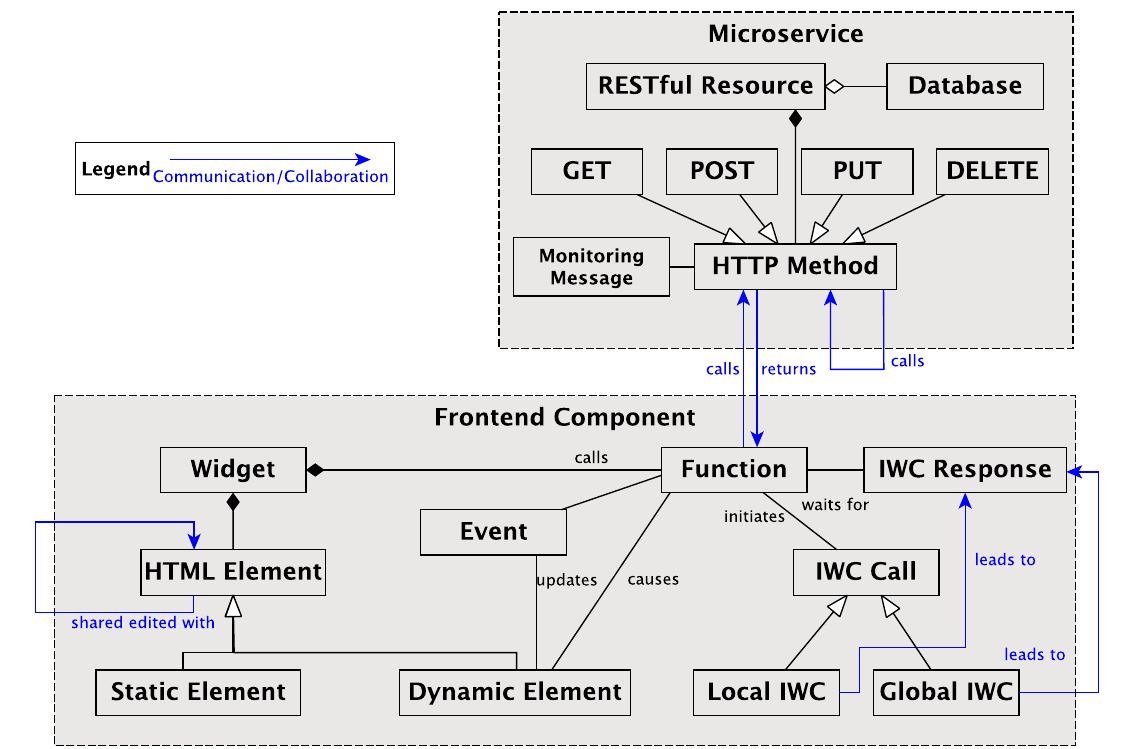
Fig. 4 The Web application metamodel used in this